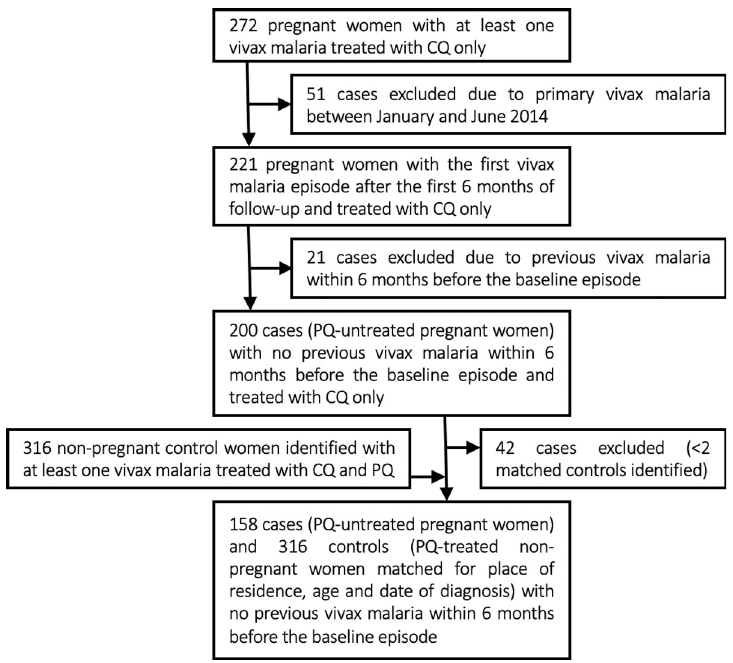
Fig 1. Study flow diagram. We identified 272 women who had one or more vivax malaria episodes during pregnancy diagnosed and treated with chloroquine alone between January 2014 and September 2016, and were not administered weekly chloroquine prophylaxis after treatment. Reasons for exclusion and the final number of subjects analyzed are